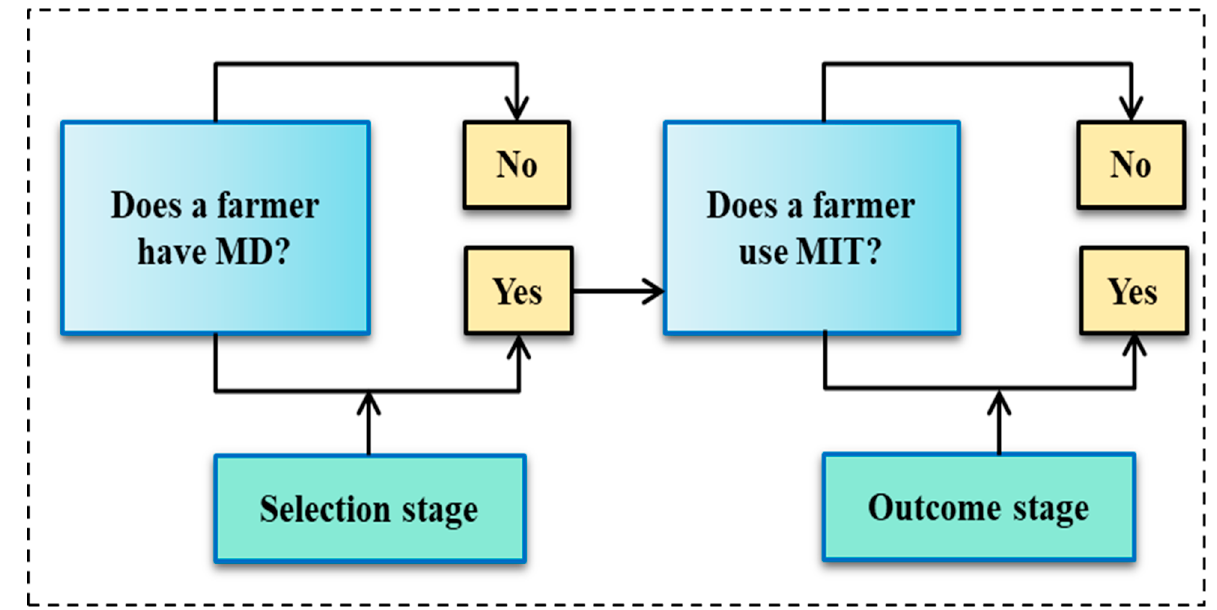
Figure 2. The bivariate probit model for sample selection for MIT adoption via wheat farmers. Note: MD = Mobile device; MIT = Mobile internet technology.